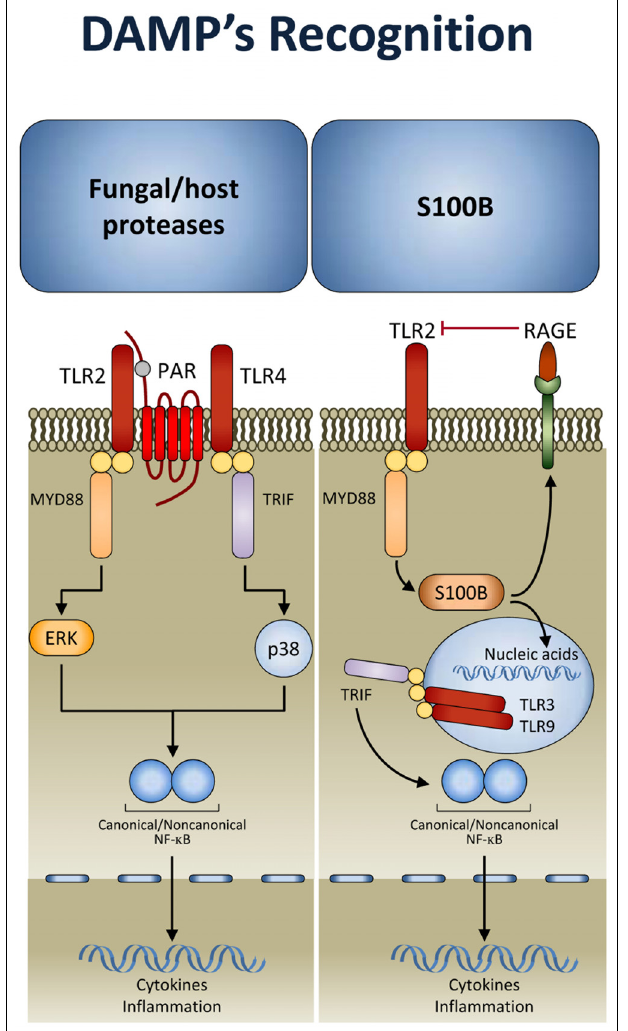
FIGURE 2 | Damage-associated molecular patterns (DAMP) signaling in response to fungi. AfterTLR activation, protease-activated receptors (PARs) sense proteolytic virulence factors and tissue injury and contribute to fungal recognition through a dual sensor system. In addition, the DAMP, S100B, through the spatio-temporal integration of signals from TLRs and RAGE, allows the immune system to discriminate between pathogen-derived and endogenous danger signals (see text for details). TRIF,TIR domain-containing adaptor protein inducing IFN- β ; MYD88, myeloid differentiation primary response protein 88; RAGE, receptor for advanced glycation